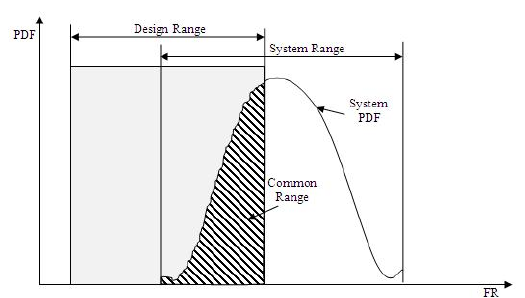
Figure 3. System design, design range, and common area